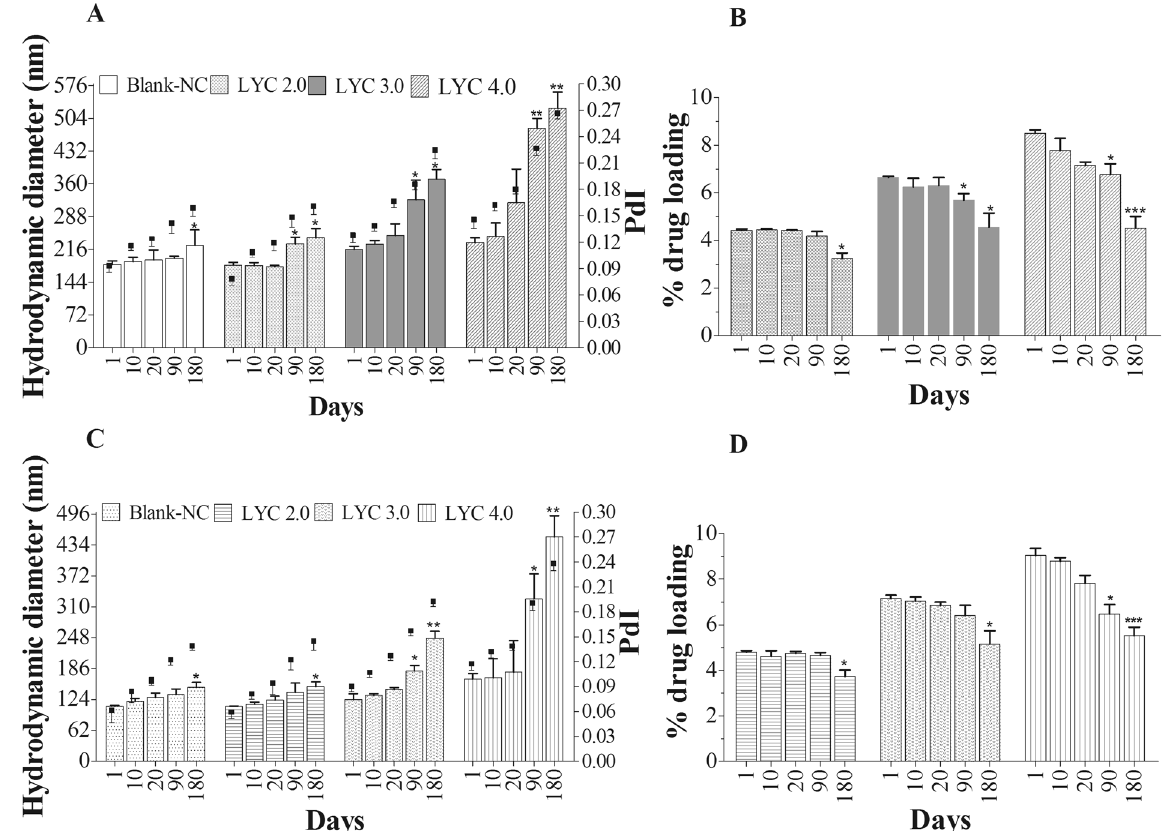
Figure 1. Physical stability of lychnopholide (LYC) nanocapsules of PCL ( A and B ) and PLA-PEG ( C and D ) up to 6 month storage at 4 °C. Mean hydrodynamic diameters are shown on the left axis and polydispersity index on the right axis ( A and C ); LYC loading (wt% ± SD) in graphs ( B and D ). Blank-NC are nanocapsules without LYC. * Indicates 0.01 ≤ p < 0.05; ** indicates 0.001 ≤ p < 0.01; *** indicates p < 0.001 compared to day